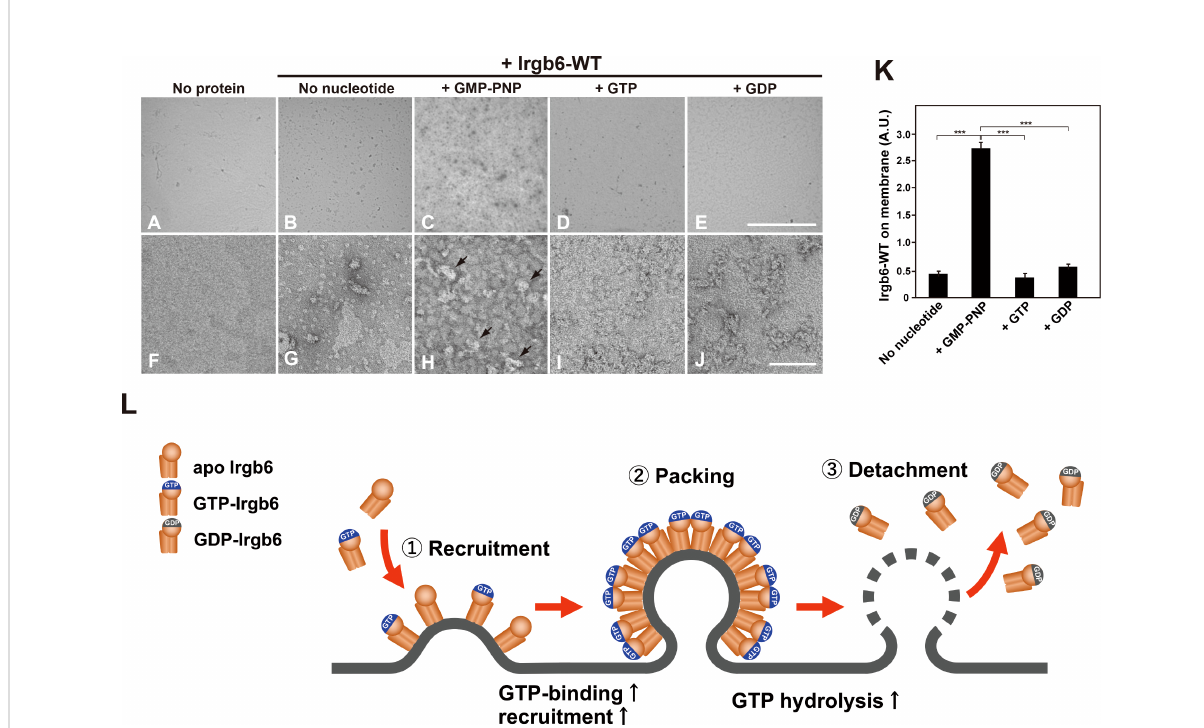
FIGURE 4 Nucleotide-dependent binding of Irgb6 to PI5P-containing lipid monolayers. (A – J) Increased binding of Irgb6 to the lipid monolayers containing PI5P in the presence of GMP-PNP. Three m M Irgb6-WT was absorbed to the lipid monolayers without nucleotide (B, G) , or with 1 mM GMP-PNP (C, H) , GTP (D, I) or GDP (E, J) at room temperature for 3 h. TEM image of monolayer without Irgb6 is shown as a negative control (A, F) . TEM images taken at 300× (upper panels) or at 30000× (bottom panels) were shown. Note that binding of Irgb6-WT to monolayers was remarkedly increased in the presence of GMP-PNP (H) , and some appeared bulged (arrowheads in H ). Scale bar: 8.6 m m in upper panels (A – E) , 100 nm in bottom panels (F – J) . (K) Quanti fi cation of binding of Irgb6-WT to monolayers. Irgb6-WT on the lipid monolayers could be visible in negatively stained TEM images (512 x 512 pixel) taken as in (A – E) at low magni fi cation. The area corresponding Irgb6-WT in TEM image was quanti fi ed using Image J from three to four independent grids. (***P < 0.0001). (L) Model for the molecular machinery of Irgb6 in PVM disruption. Recruitment of Irgb6 to the membrane leads to membrane deformation. The membrane binding is increased at GTP-binding state because of GTP-dependent polymerization of Irgb6. Dense packing of Irgb6 on lipid membrane results in the stimulation of GTPase activity, and upon GTP hydrolysis Irgb6 detaches from the membrane accompanying membrane